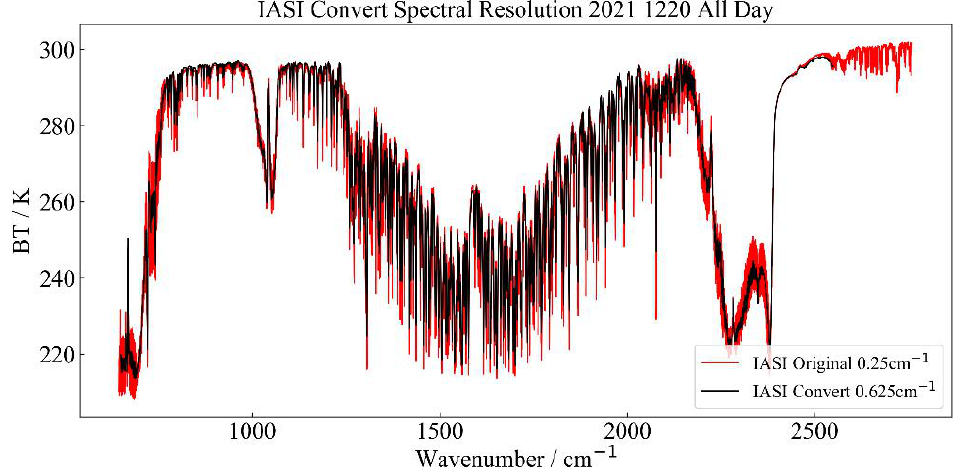
Figure 4. Comparison before and after IASI spectral